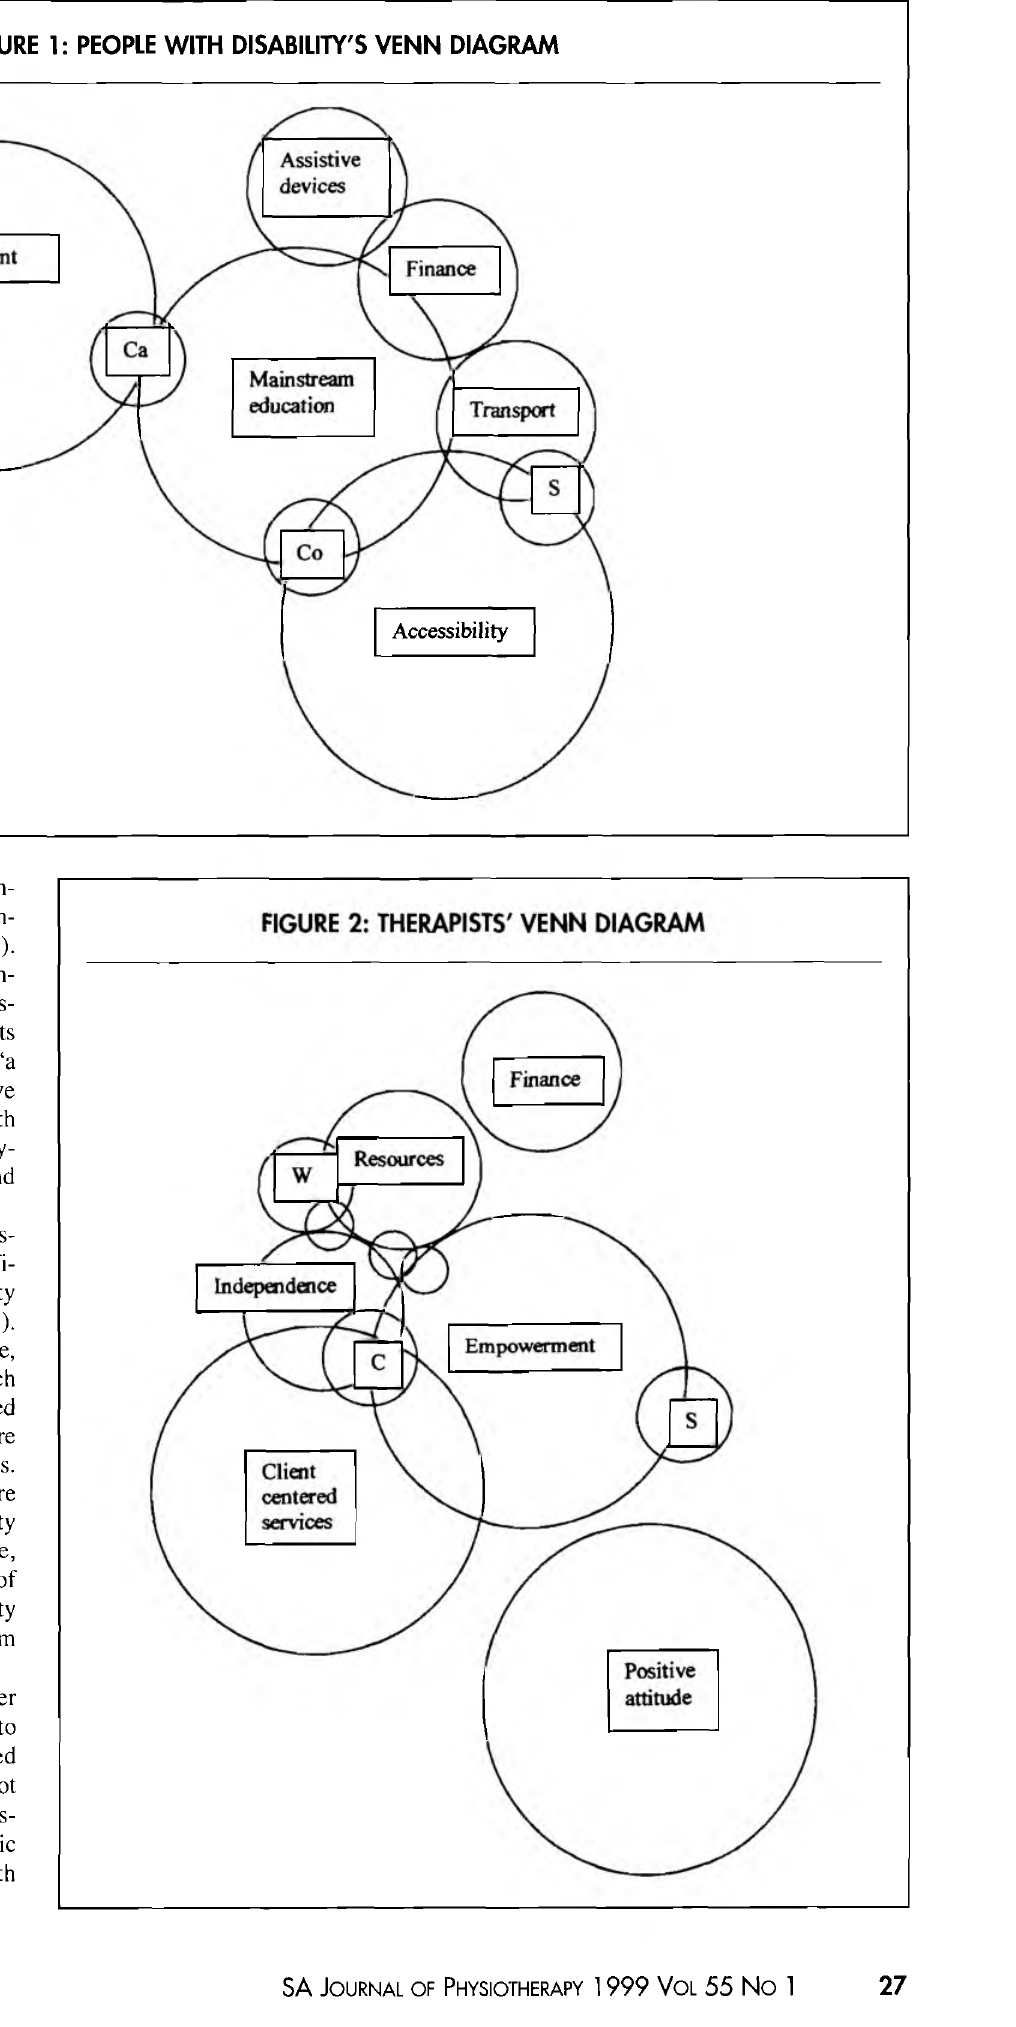
FIGURE 1: PEOPLE WITH DISABILITY'S VENN